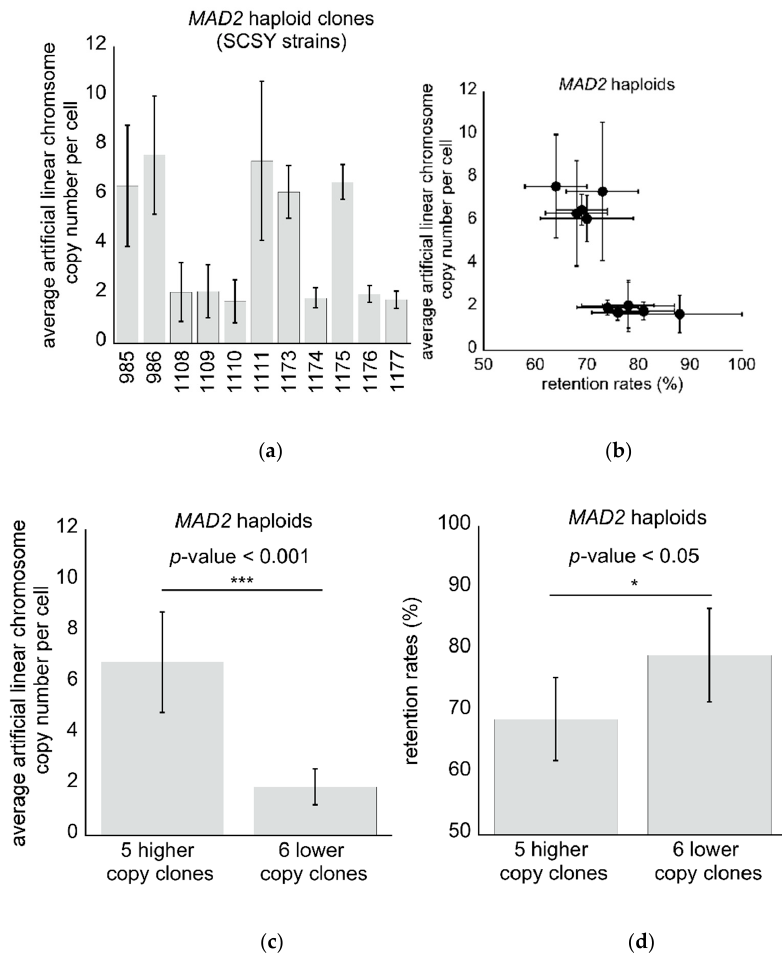
Figure 2. Genetically identical wild type MAD2 haploid clones have an unexpected phenotype displaying clone-to-clone differences: ( a ) The measured average artificial linear chromosome copy number per cell for 11 clones ( n = 8 for qPCR; n = 6 for retention rates), where the values are displayed as the mean ± standard deviation; ( b ) MAD2 haploid clones cluster into two phenotypic groups. The graph shows the measured average artificial linear chromosome copy numbers per cell versus the measured retention rates, where values are displayed as the mean ± standard deviation; ( c ) The average artificial linear chromosome copy numbers are significantly different between the higher copy and lower copy clones ( p -value < 0.001 denoted by ***, Student’s t -test); ( d ) The average retention rates are significantly different between the higher copy and lower copy clones ( p -value < 0.05 denoted by *, Student’s t -test).